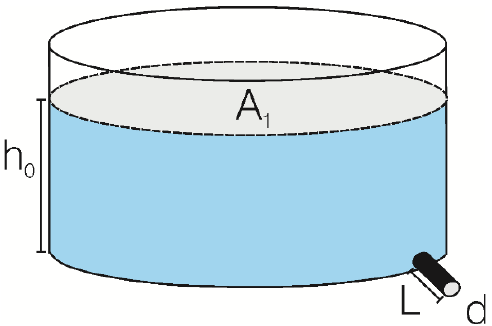
Figure 1. Cylindrical tank-reservoir, with a base A 1 . Water discharge occurs through a bottom tank-tube, with diameter d and length L, starting from an initial water height h 0 .